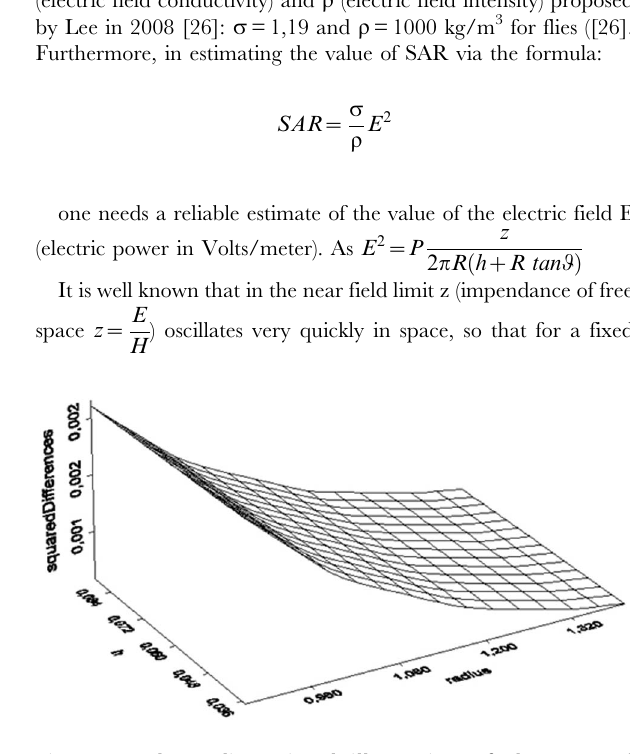
Figure 4. Three dimensional illustration of the squared differences between 1880 and 900 MHz vs h and